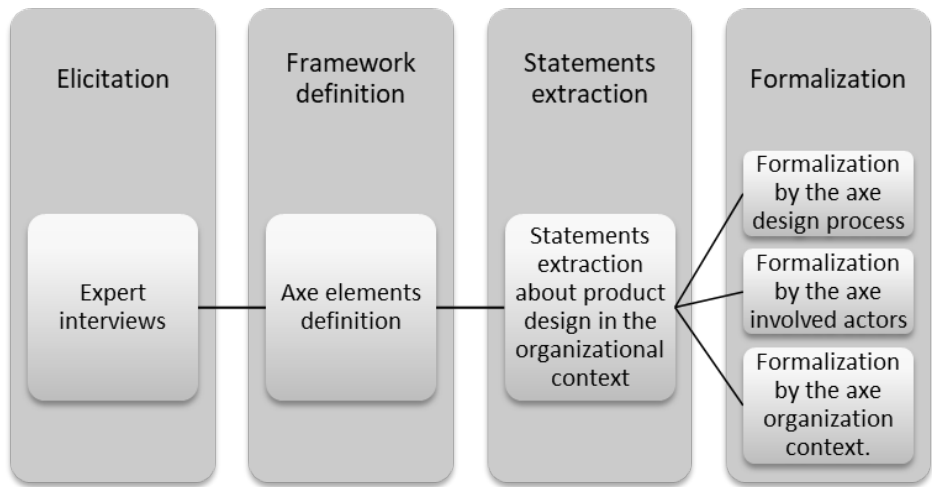
Figure 1. Method for the construction of the knowledge base.